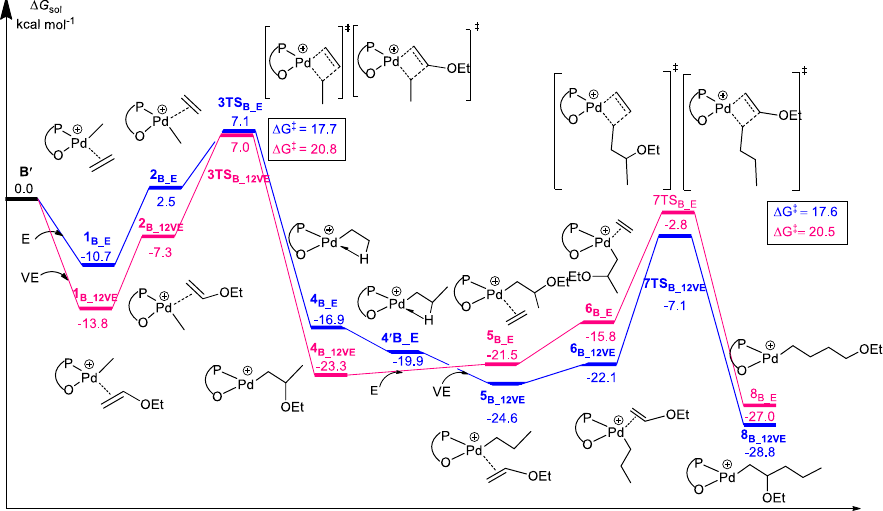
Figure 8. Computed energy profiles for ethylene and VE copolymerization catalyzed by B .